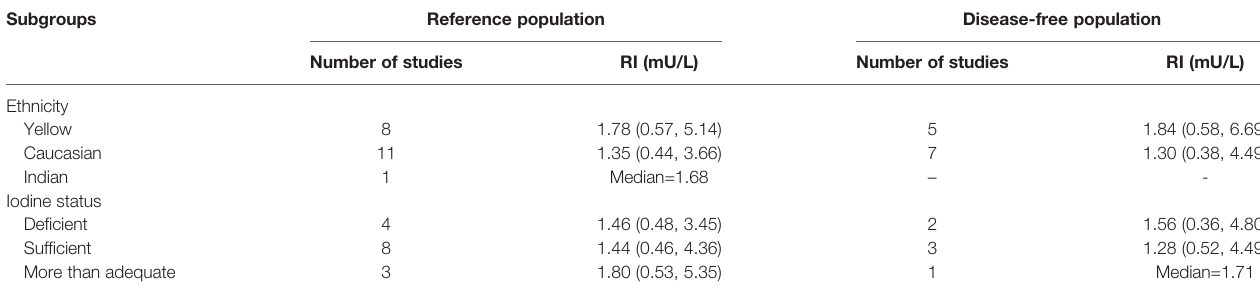
TABLE 2 | The reference interval of TSH strati fi ed by ethnicity and iodine status in the reference and disease-free population.